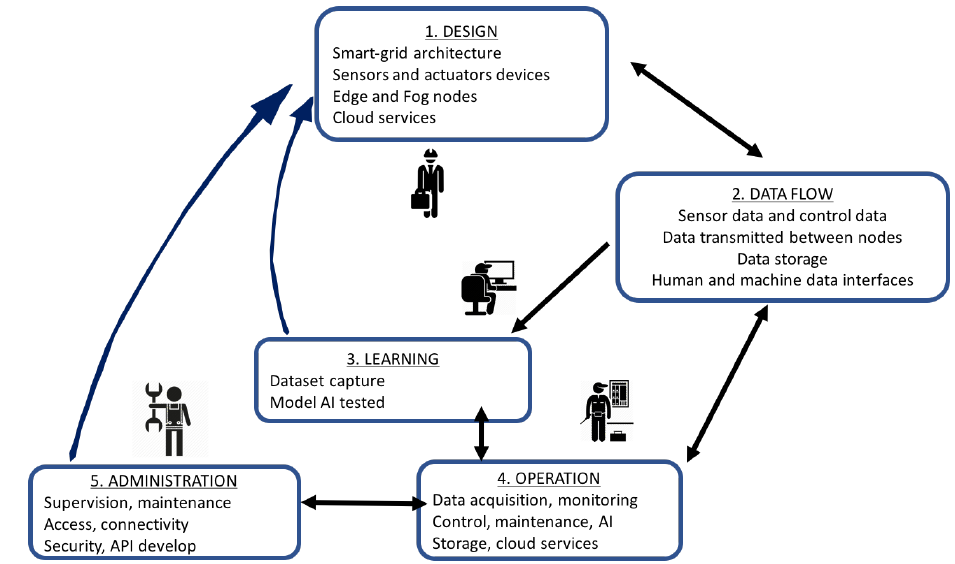
Figure 5. Computing